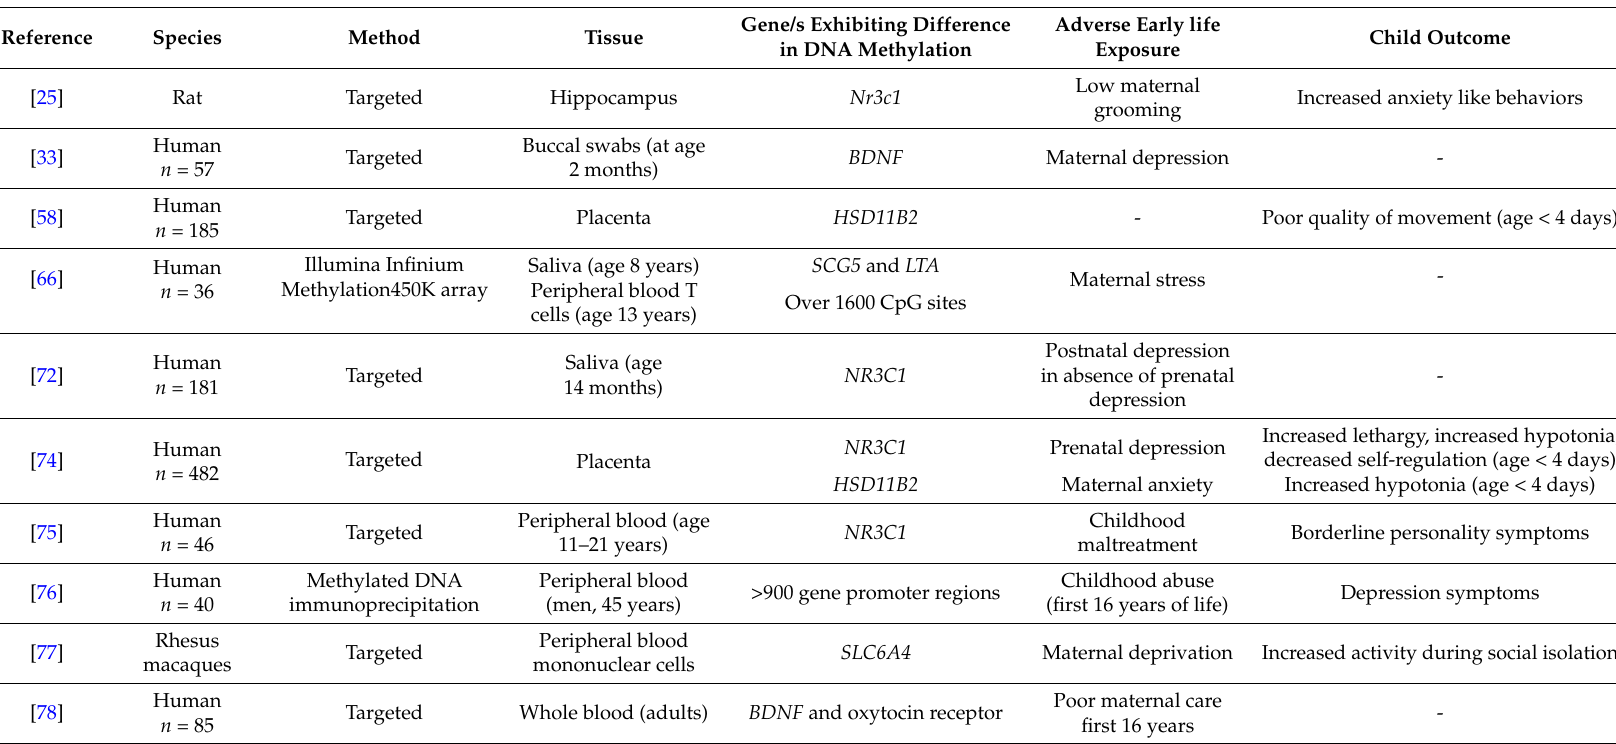
Table 2. Summary of studies assessing changes in tissue DNA methylation associated with an adverse prenatal exposure and/or child neurodevelopmental